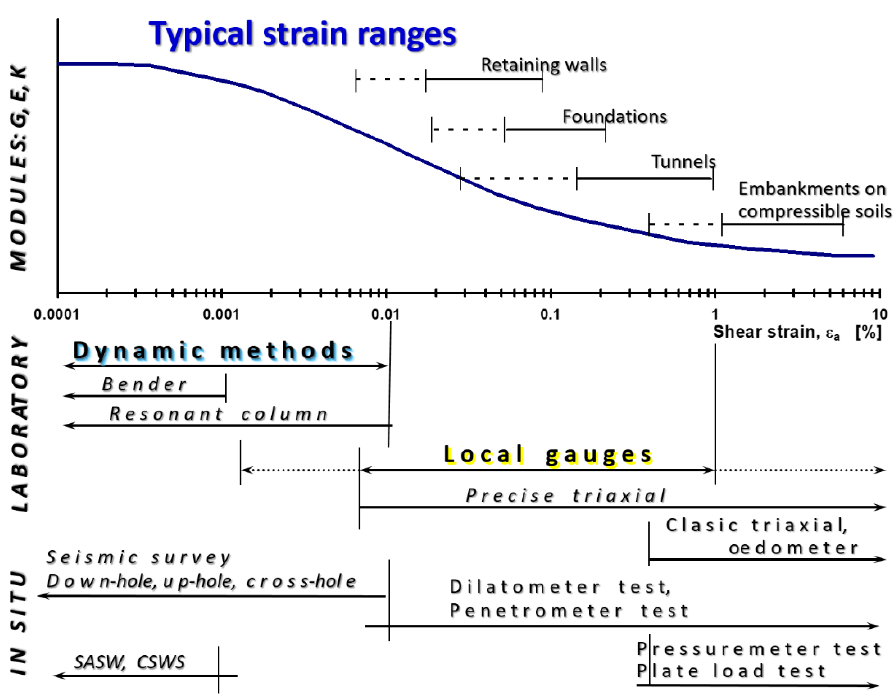
Figure 9. Approximate strain ranges corresponding to various measuring techniques of soil stiffness characteristics in laboratory and field tests, with the strain range marked by the typical geotechnical construction work (on the basis of [49 – 52]).